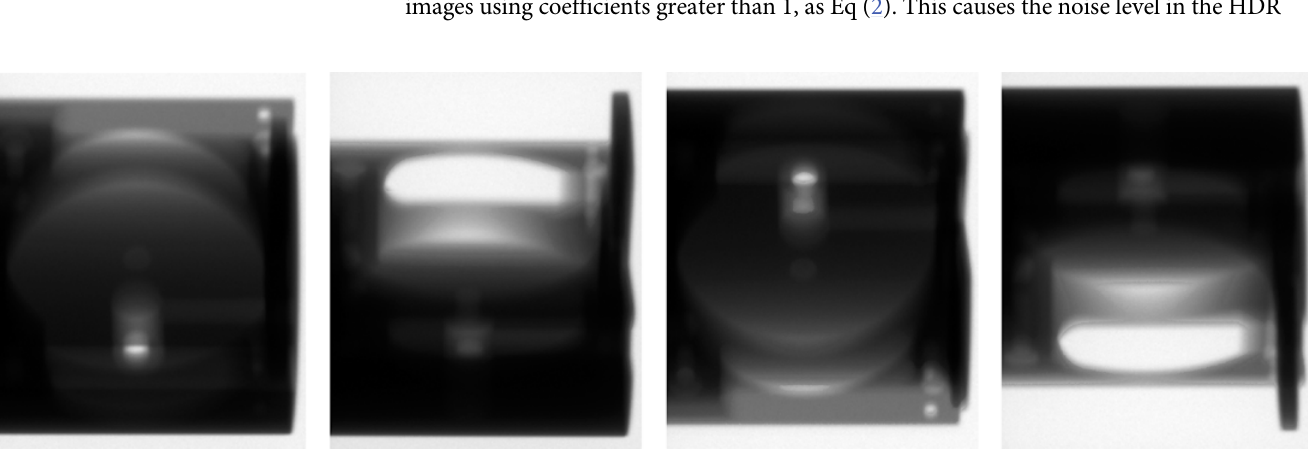
Fig 8. The fused HDR projections at 0°, 90°, 180°, and